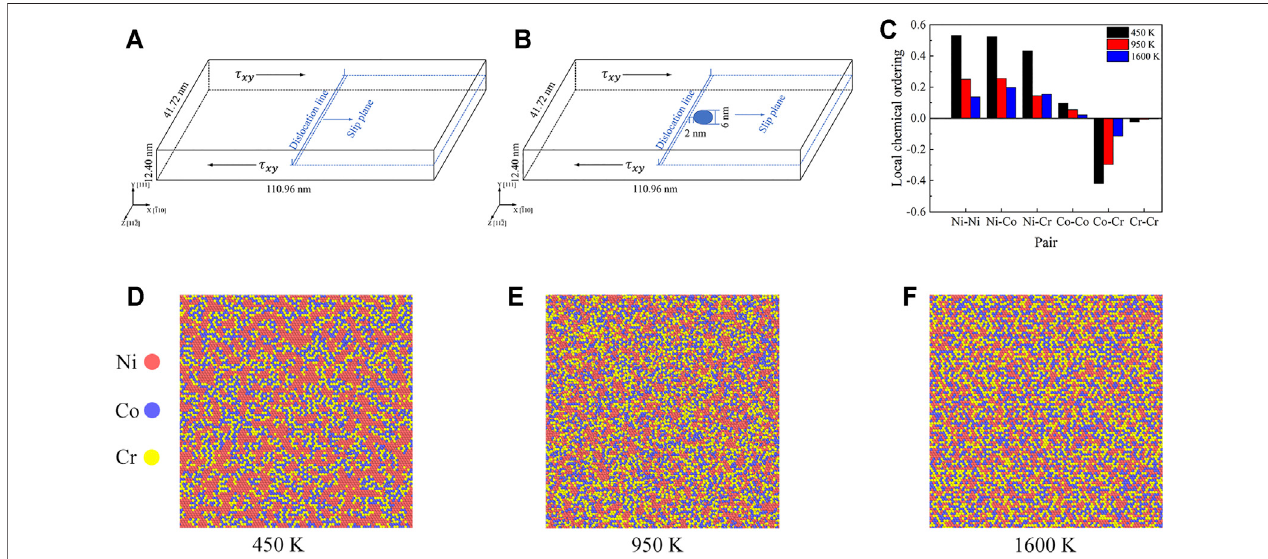
FIGURE 1 | (A) Con fi guration for shear deformation on simulation cell with a straight a/2 < 110 > edge dislocation and without nanoprecipitates. (B) Con fi guration for shear deformation on simulation cell with a straight a/2 < 110 > edge dislocation and with nanoprecipitates. (C) The parameters of local chemical ordering for various pairs for the samples annealed at three different temperatures. (D) (E) (F) The typical atomic con fi gurations with the detailed element distributions for the samples annealed at three different temperatures (Ta, 450, 950, 1600 K), in which the Ni atoms are colored in red, the Co atoms are colored in blue, and the Cr atoms are colored in